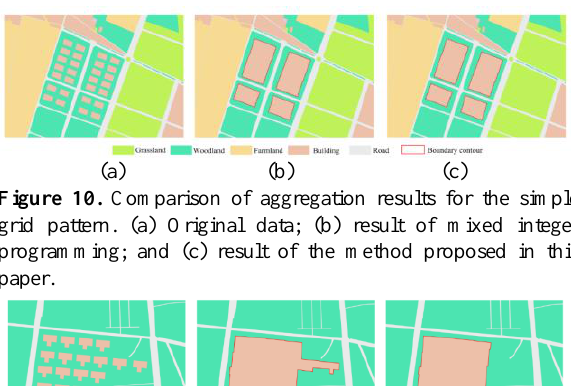
Figure 9. Comparison of aggregation results for the complex linear pattern. (a) Original data; (b) result of mixed integer